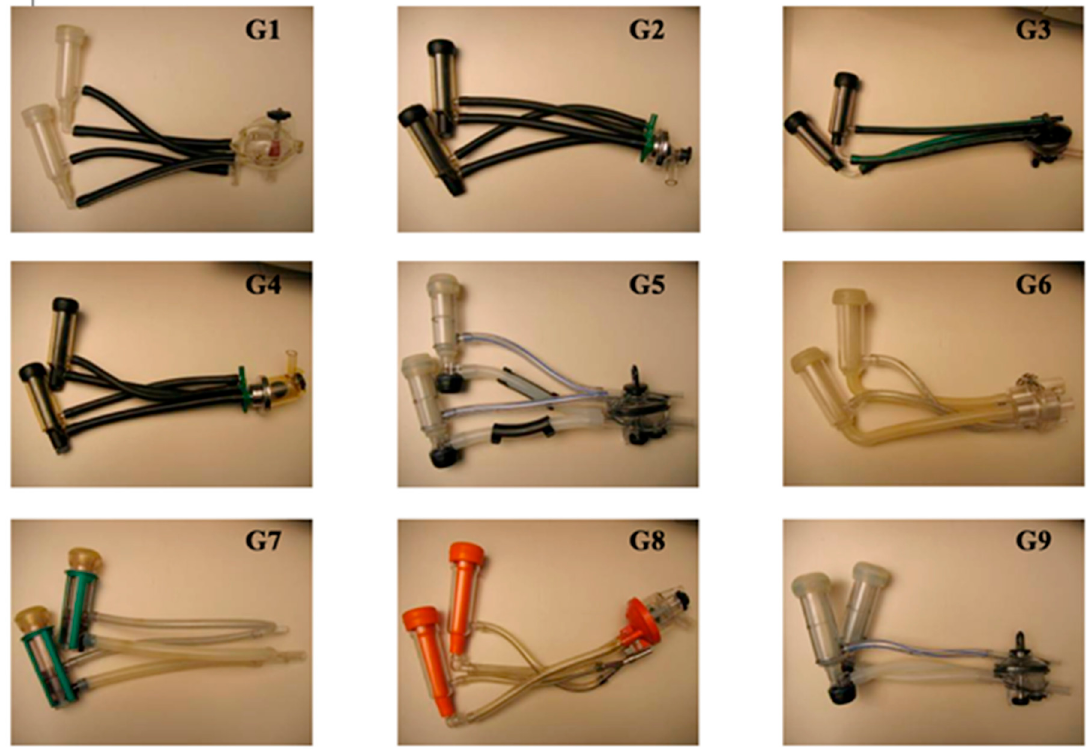
Figure 1. Milking units with di ff erent characteristics ( G1 – G9 ) adopted in the experimental trials.